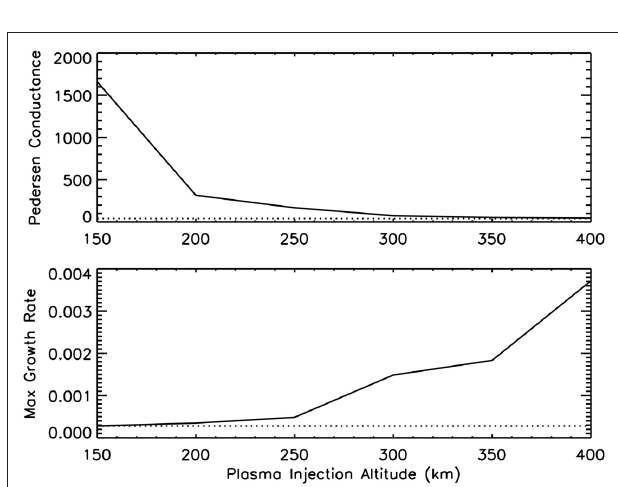
FIGURE 4 | The Top shows the Pedersen conductance (mho) of the field line outlined in the left panel of Figure 1 for simulations with plasma releases at different altitudes. In each simulation 5.0 × 10 7 Al + ions were released at a different location along the field line. The dotted line denotes the Pedersen conductance for a simulation with no plasma release. The Bottom shows the maximum growth rate (s − 1 ) for a the same series of simulations as the Top . The dotted line shows the maximum growth rate for a simulation with no plasma release.